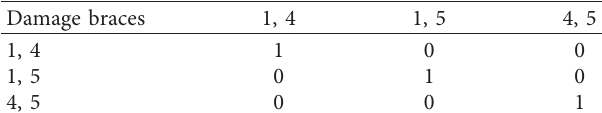
Table 5: Target outputs of the first BPNN model and the corre- sponding damage patterns for multiple damage